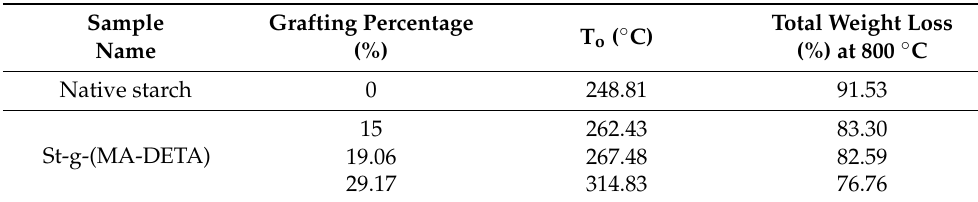
Table 4. The effect of grafting percentage on the initial decomposition temperature (T o ) value of St-g-(MA-DETA)